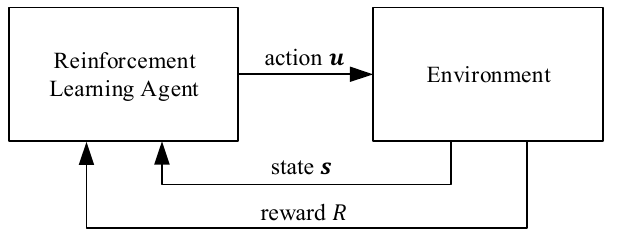
Figure 3. Agent-environment interaction in a Markov decision process [5].